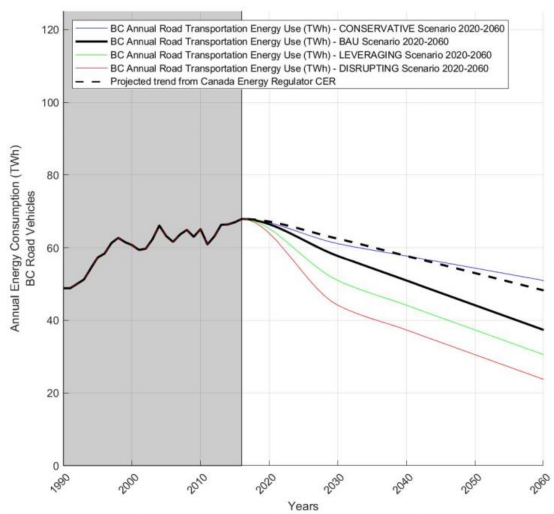
Figure 8. B.C. road transportation annual energy use in (TWh), impacts of vehicle